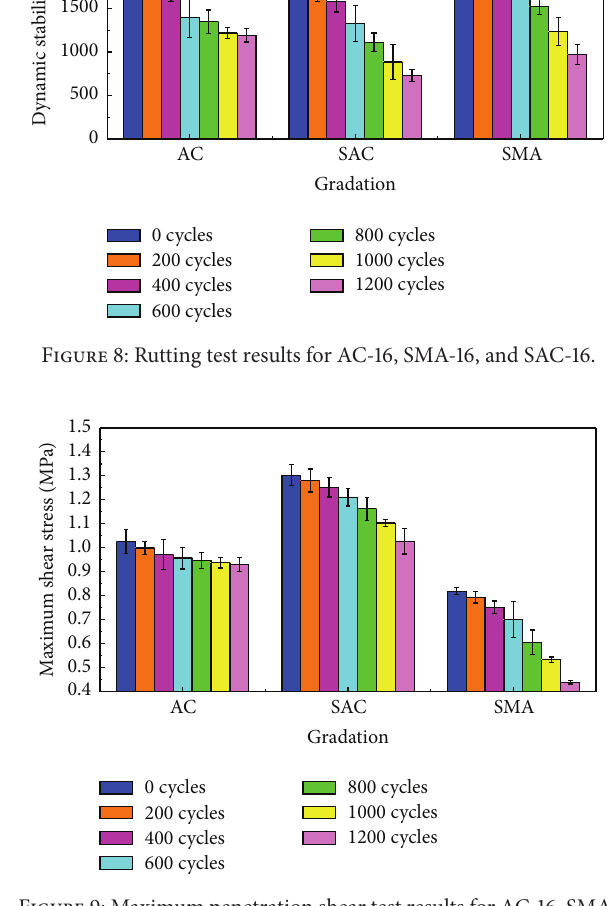
Figure 9: Maximum penetration shear test results for AC-16, SMA- 16, and SAC-16.